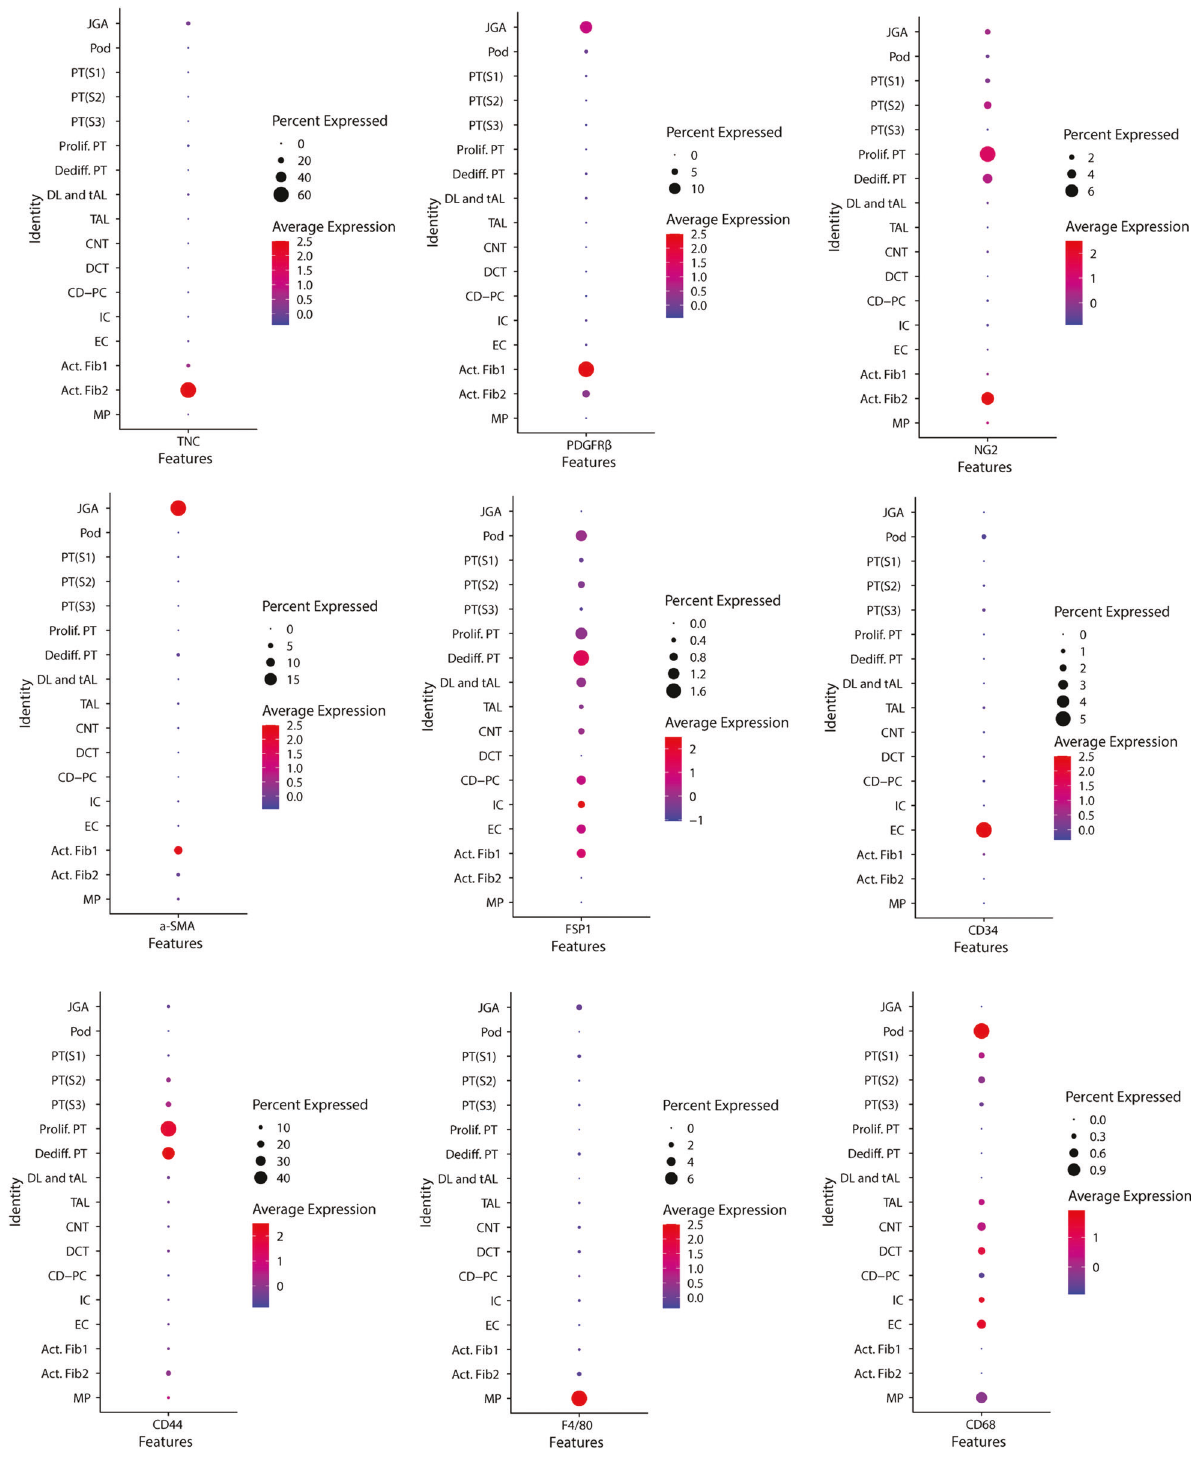
Fig. 8 Single nucleus RNA-seq identi fi ed TNC-expressing fi broblasts in mouse UUO kidneys. A previously generated single nucleus RNA- seq dataset pro fi ling kidney of mouse UUO model at day 14 was used for re-analysis. Two subpopulations of activated fi broblasts were identi fi ed, with distinct TNC-expression pattern. Around 60% of activated fi broblast 2 (Act.Fib2) expressed TNC, while less than 5% of activated fi broblast 1 expressed TNC. It was observed that around 6% of activated fi broblast 2 expressed PDGFR β , NG2 and CD44. Fibroblasts were almost completely negative in FSP1, CD34, F4/80 and CD68. JGA juxtaglomerular apparatus; Pod podocyte; PT proximal tubule; Prolif proliferating; Dediff dedifferenciated; DL descending limb; tAL thin ascending limb; TAL thick ascending limb; CNT connecting tubule; DCT distal convoluted tubule; CD-PC collecting duct-principal cell; IC intercalated cell; EC endothelial cell; Act activating; Fib fi broblast; MP macrophage.